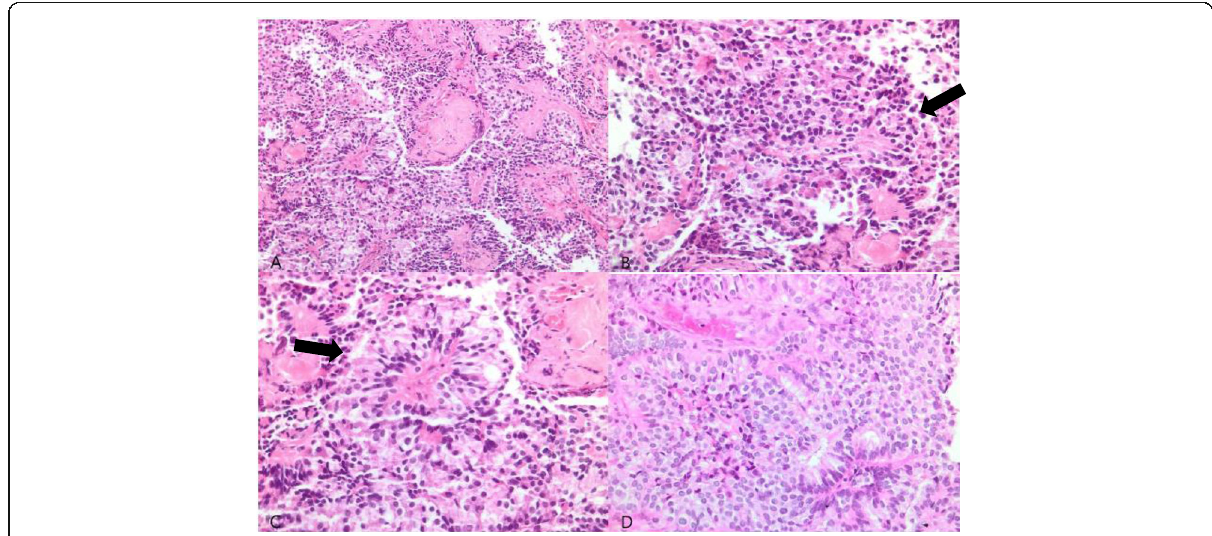
Fig. 2 Photomicrographs showing histopathological features of the tumor (hematoxylin and eosin staining). Papillary regions demonstrated with